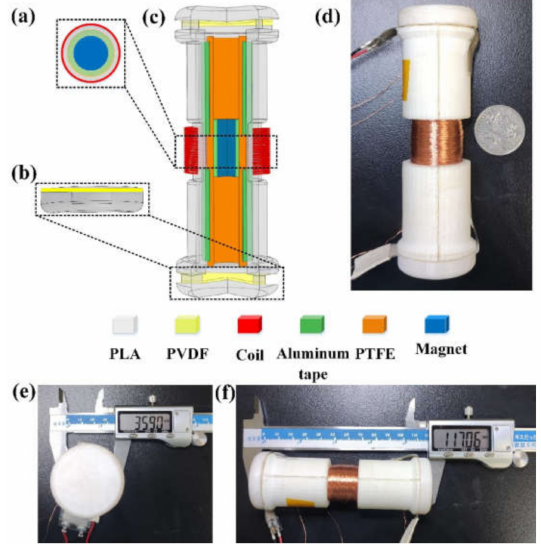
Figure 1. Structure of the piezoelectric–electromagnetic–triboelectric hybrid energy harvester. ( a ) TENG-EMG unit. ( b ) PEG unit simply supported beam structure. ( c ) Three-dimensional (3D) schematic diagram of the proposed hybrid energy harvester. ( d ) Photograph of the hybrid energy harvester. ( e , f ) The diameter and length of the hybrid energy